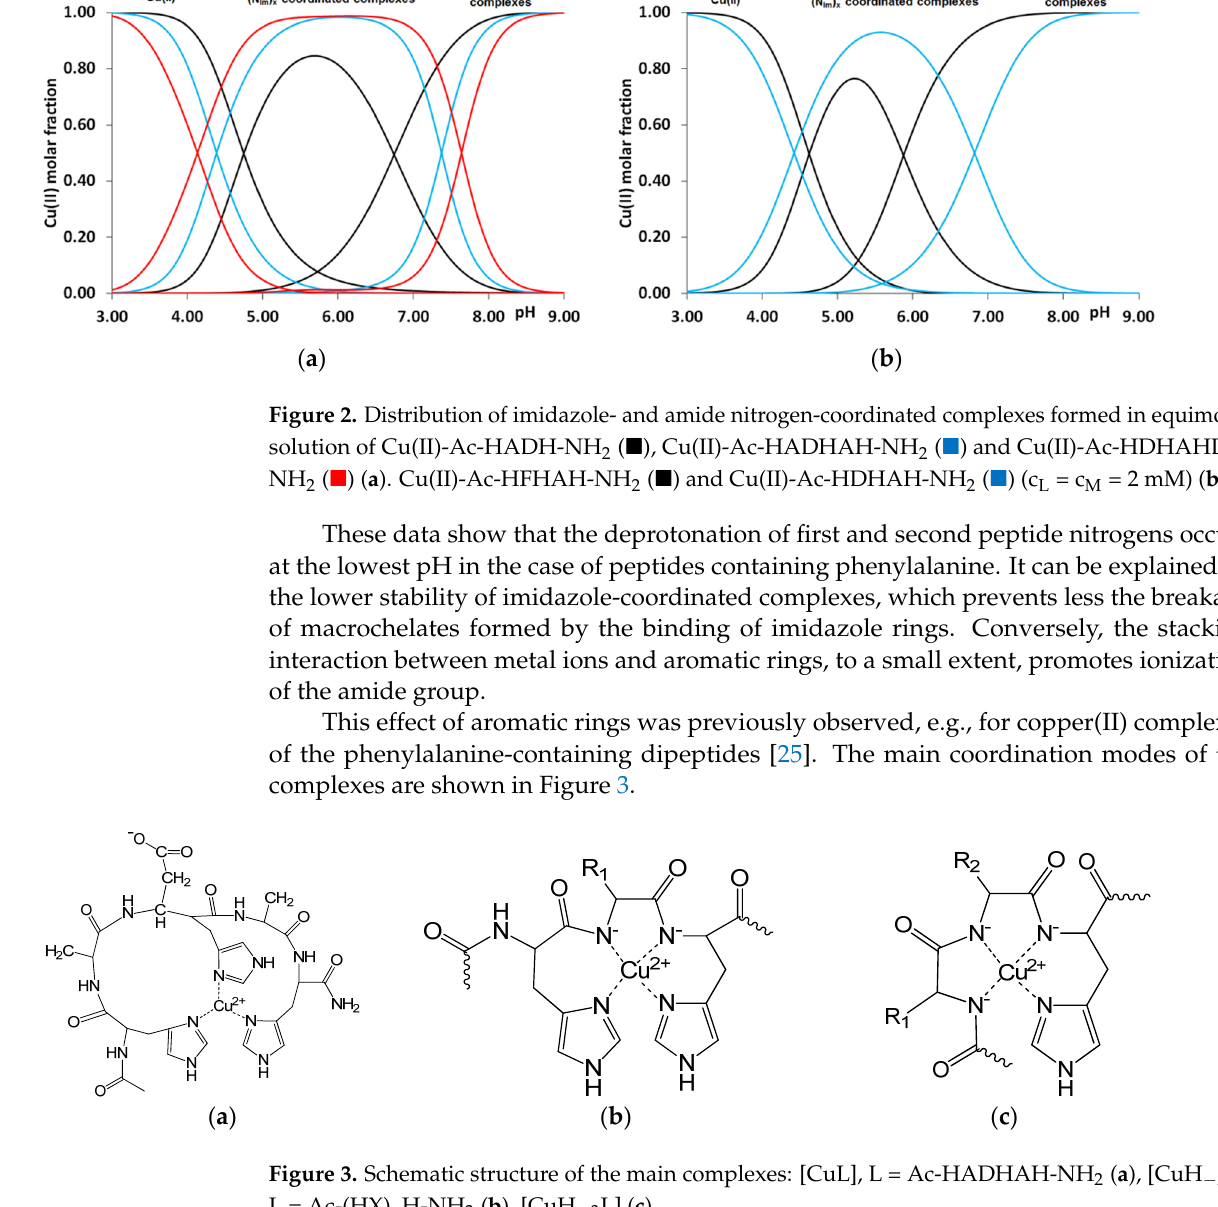
Figure 1. Equilibrium constants of imidazole-coordinated copper(II) complexes (log K (M + z(N Im ))) of various histidine-containing peptides (data from refs. [8,9,13]); ( ■ ) data-related complexes of pep- tides containing aspartic acid.